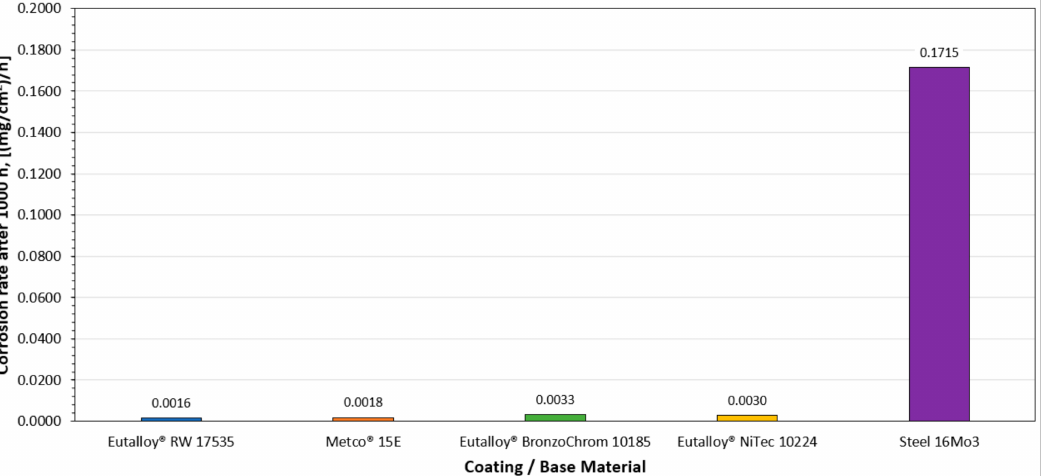
Figure 7. Graph of corrosion rate of protective coatings and base material exposed to corrosive atmosphere at 800 ◦ C for 1000